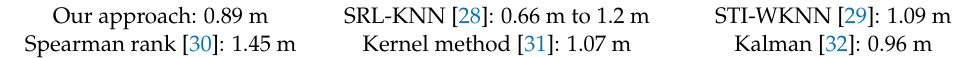
Table 3. Comparison of the average errors. Our approach: 0.89 m